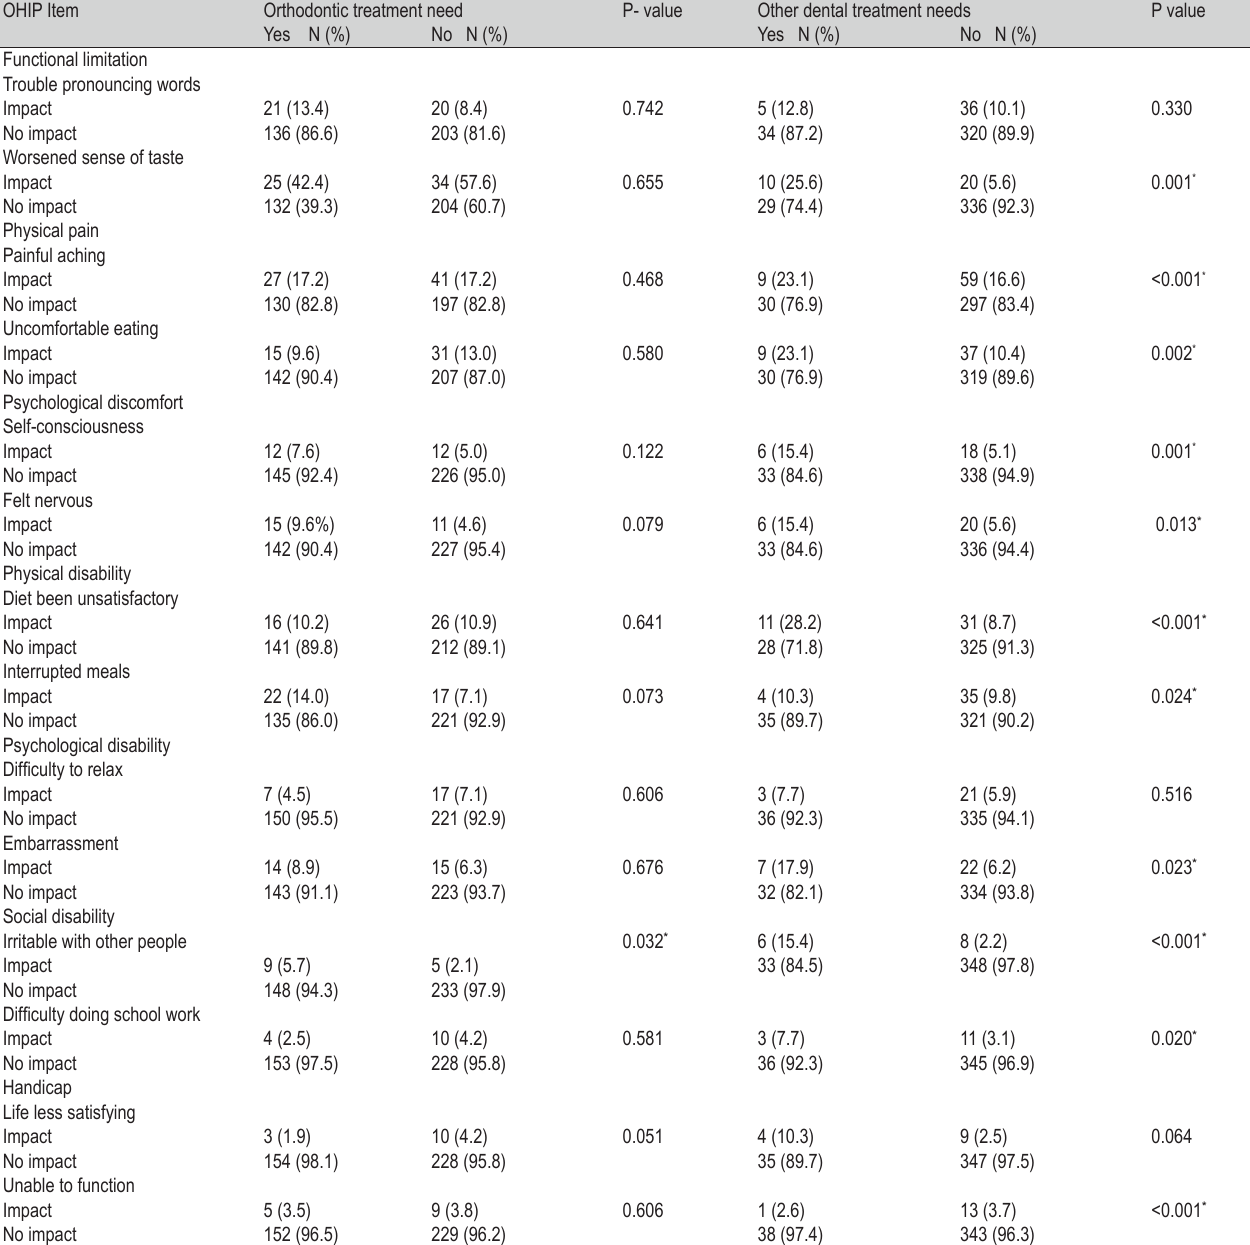
Table 3 - relationship between the OHIP-14 questionnaire items and the various unmet dental treatment